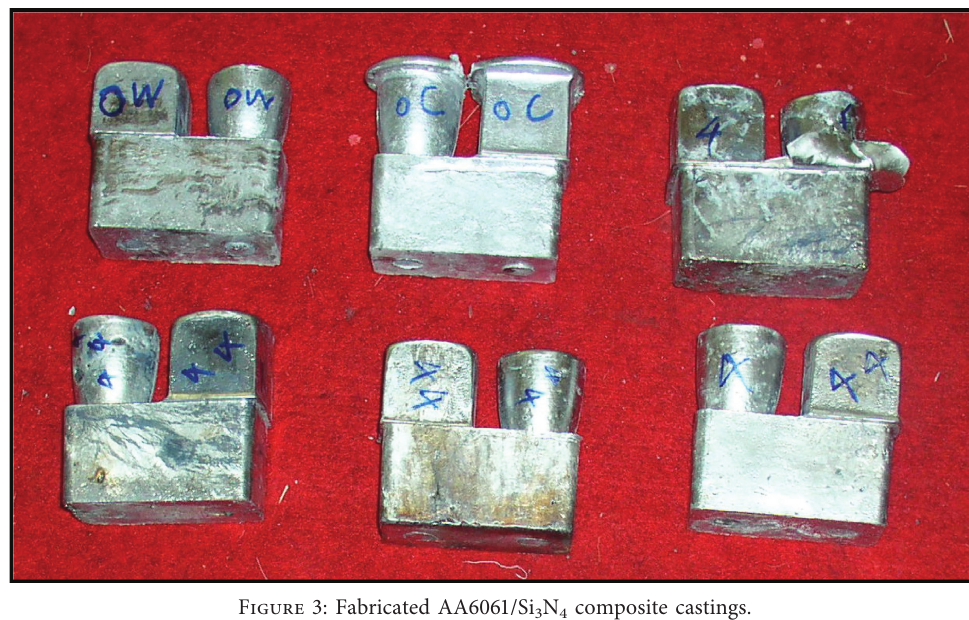
3 N 4 composite